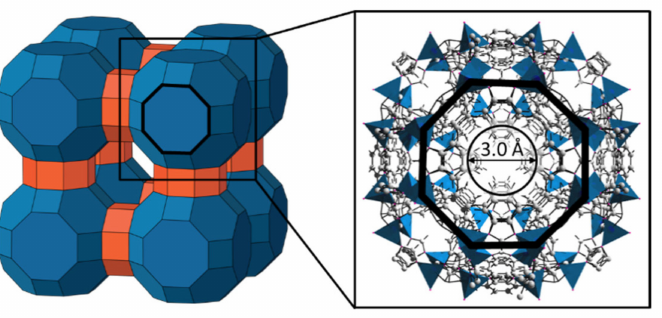
Figure 1. Schematic representation of the RHO topology of ZIF-11 ( left ) and detailed representation of the LTA unit and the resulting pore aperture ( right